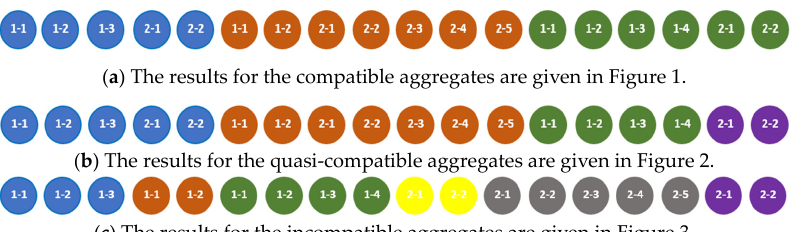
Figure 1. An example of two compatible aggregates. Figure 2. An example of two quasi-compatible aggregates. Definition 4. Aggregates 𝐴 (cid:2869) and 𝐴 (cid:2870) are called incompatible ( 𝐴 (cid:2869) ≗ 𝐴 (cid:2870) ), if the type and sequence of the sets in them do not match, that is, the condition is fulfilled: (cid:4668)𝐴 (cid:2869) (cid:4669) ∩ (cid:4668)𝐴 (cid:2870) (cid:4669) = ∅.